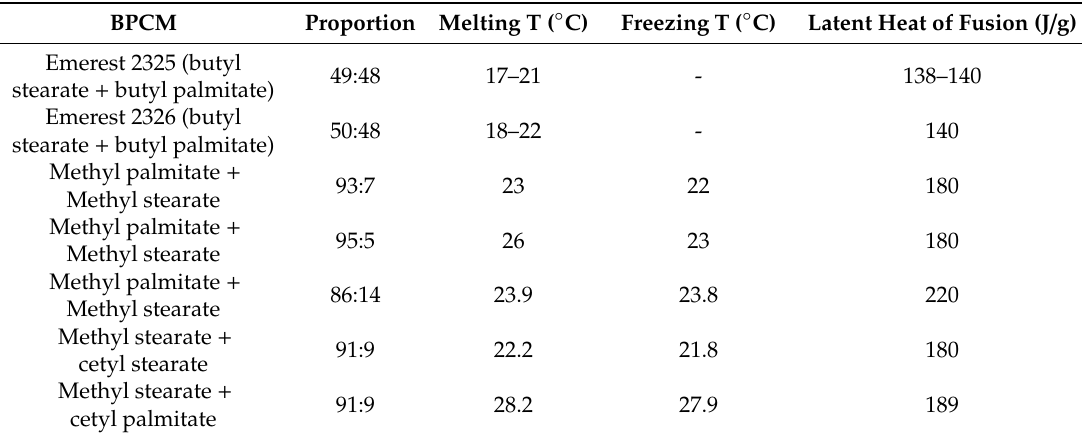
Table 4. Properties of eutectic mixtures of fatty acid esters suitable for the building application